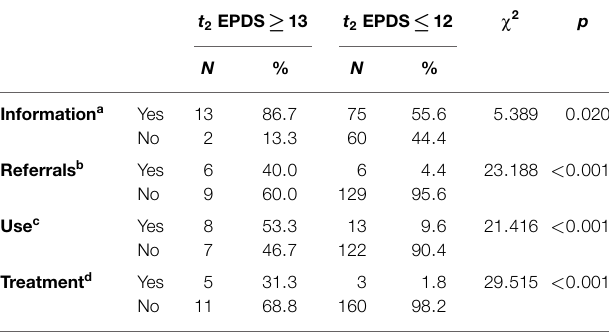
TABLE8 | Informationprovided,referrals,anduseforIGmotherswithEPDS (cid:21) 13 and (cid:20) 12, and inferential statistics